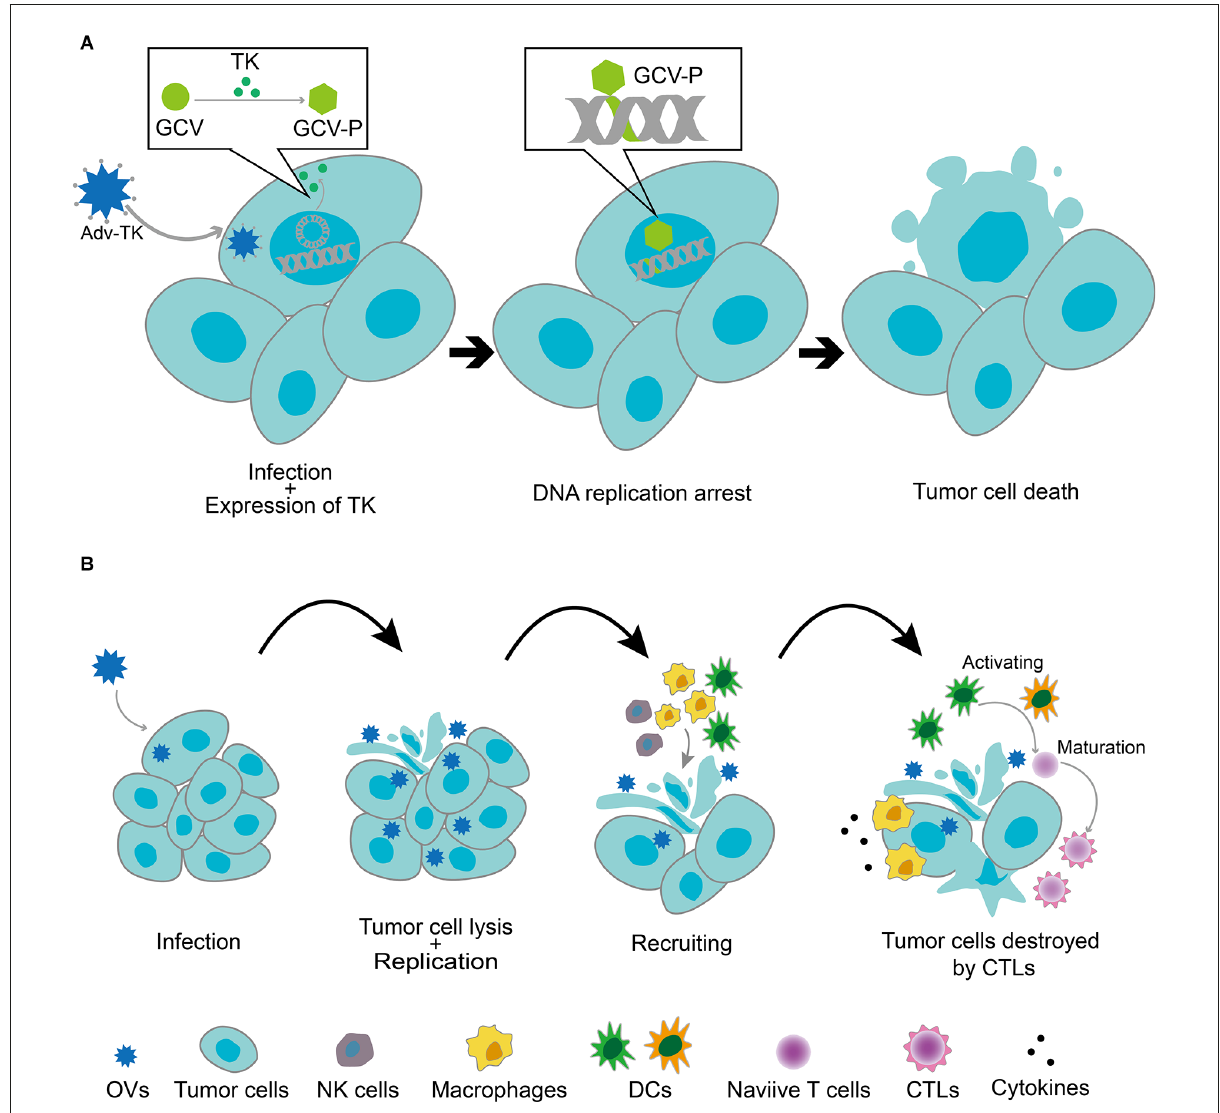
FIGURE2 (A) Replication-deficientviralvectorsinfectingtumorcellsanddeliveringanticancergenes.Afterthetumorcellswereinfectedwitharecombinant replication-deficient adenoviral vector expressing the thymidine kinase gene ( Adv-TK ), the TK gene was transcribed and translated into the nucleus. TK phosphorylated monophosphate nucleosides (e.g., ganciclovir and GCV) to triphosphate nucleosides, which then bonded to nascent DNA strands in the tumor cells, resulting in DNA replication arrest and tumor cell death. (B) Replicative viral vector (OV)-mediated antitumor mechanism. OVs selectively replicated in tumor cells and induced their lysis, releasing viral particles that further infected other tumor cells. Tumor cell lysis by OVs infection resulted in the release of tumor-associated antigens (TAAs), cell-derived damage-associated molecular patterns (DAMPs), and viral pathogen-associated molecular patterns (PAMPs), which recruited antigen-presenting cells (APCs) and innate immune